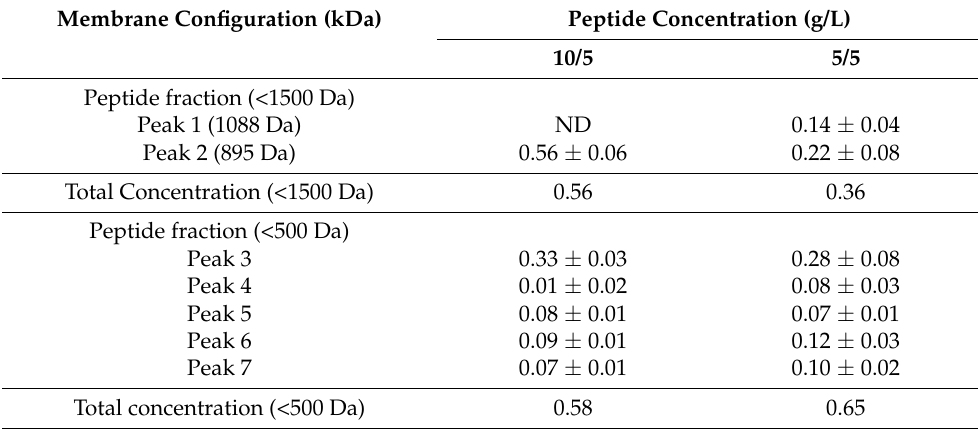
Table 1. Peptide concentration. Membrane Configuration (kDa) Peptide Concentration